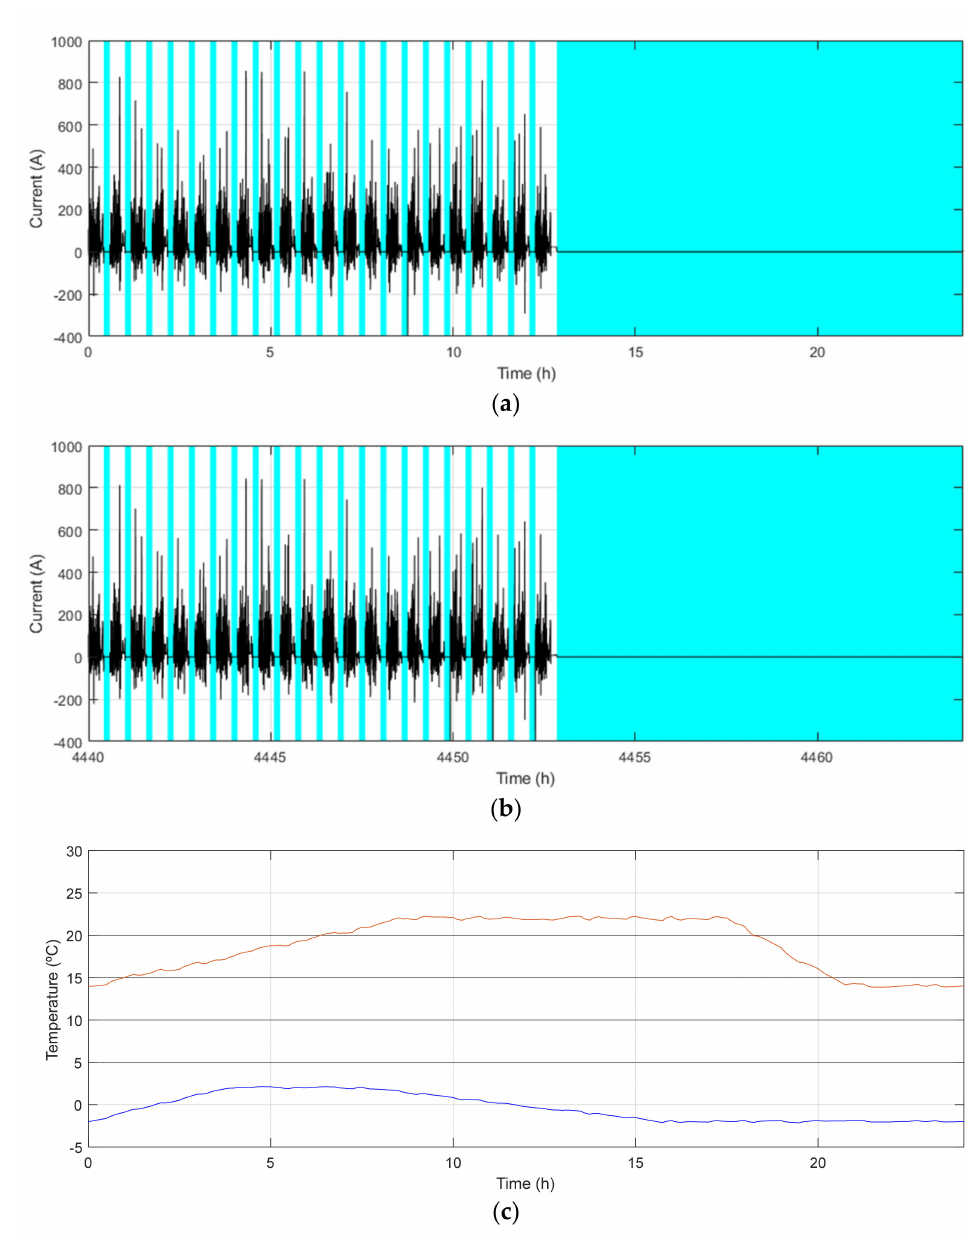
Figure 7. Current and temperature profiles in GOT scenario. ( a ) Current profile, 1 January. Cyan: Charging Points. ( b ) Current profile, 1 July. Cyan: Charging points. ( c ) Temperature Profile. Blue: January; Red: